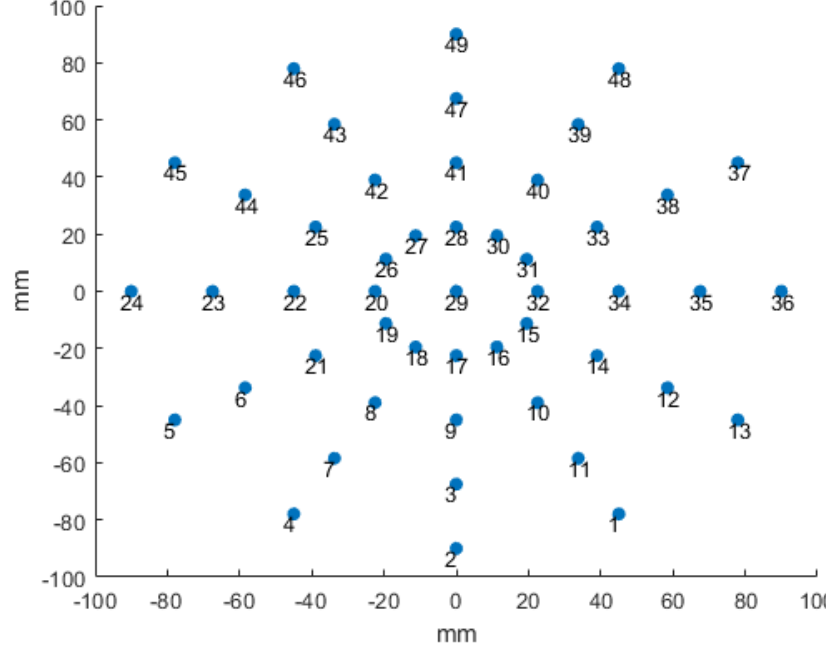
Figure 10. Coordinates of the points where deflection is measured.